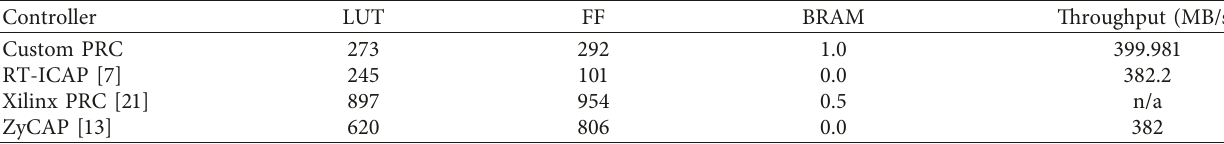
Table 4: Resource utilization and configuration throughput of the custom and other PRCs.